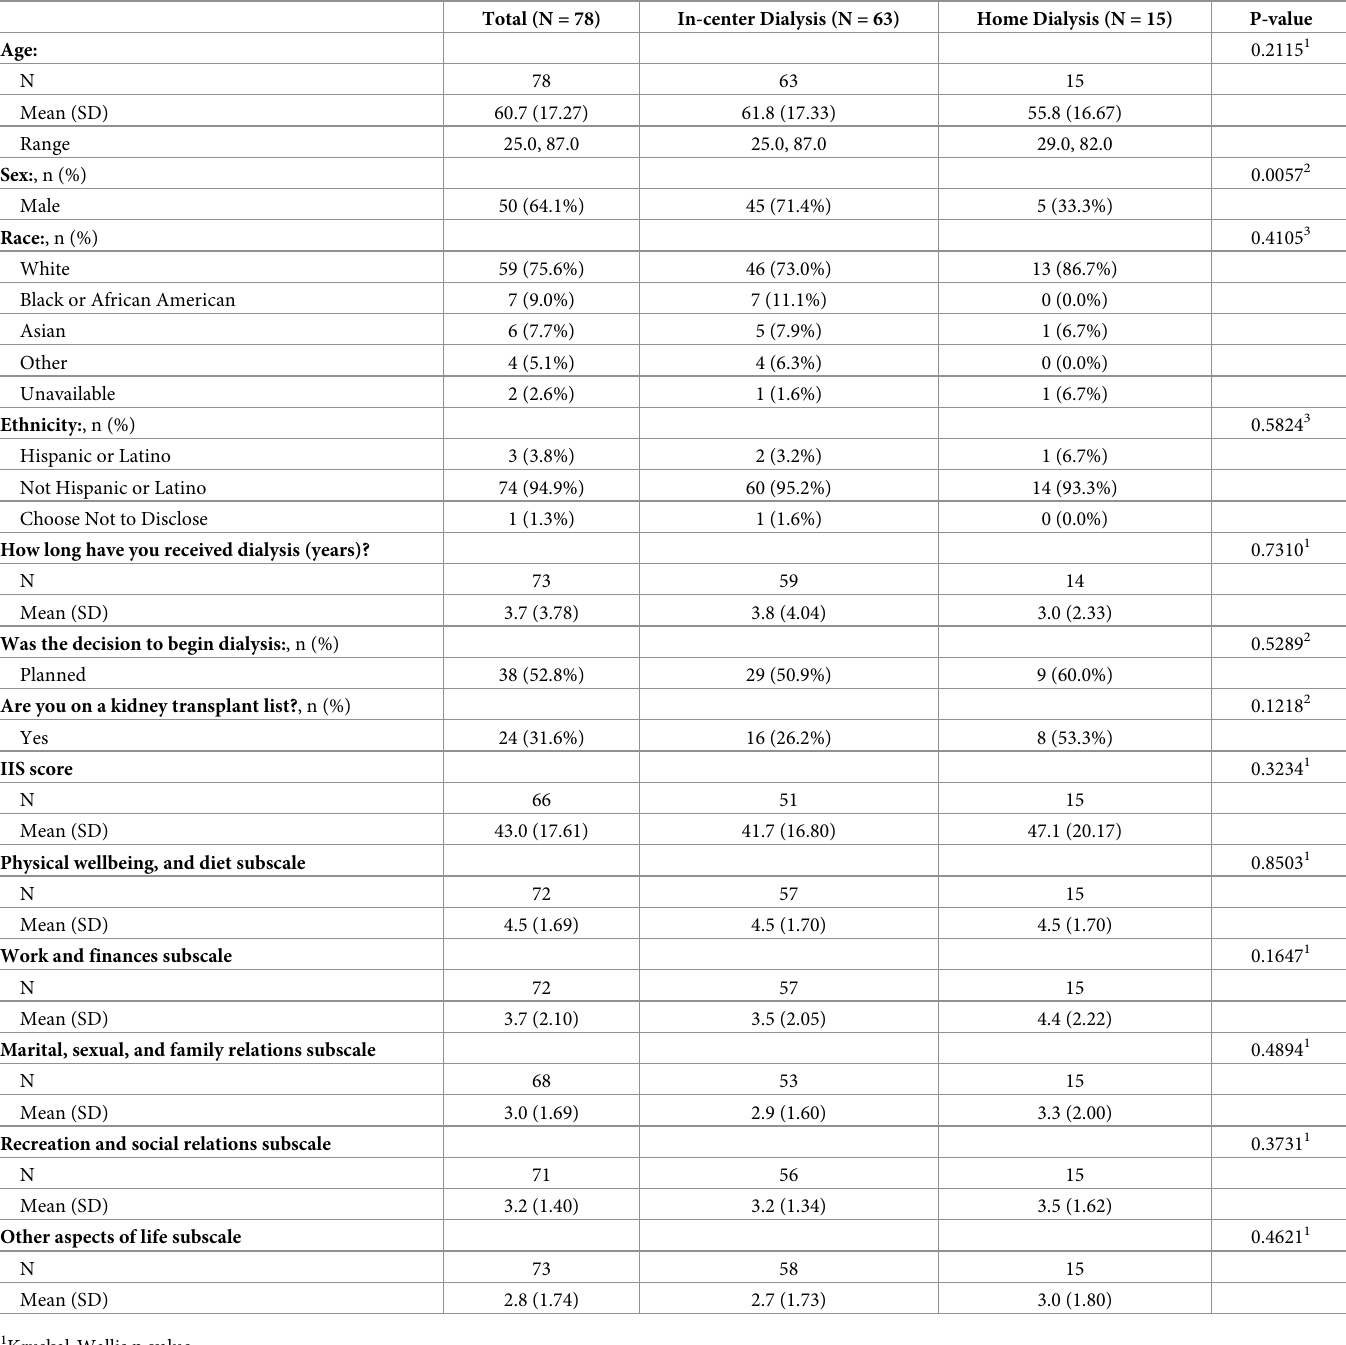
Table 2. Patient demographics by in-center versus home